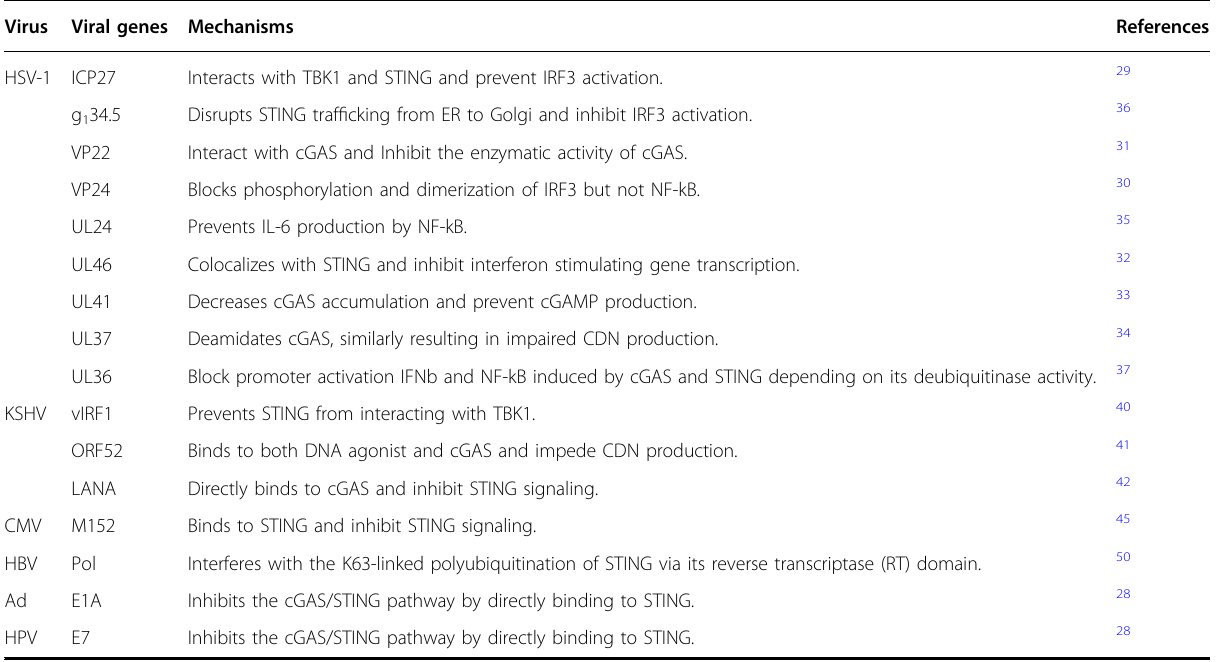
Table 1 DNA virus evasion of STING-dependent innate immunity Virus Viral genes